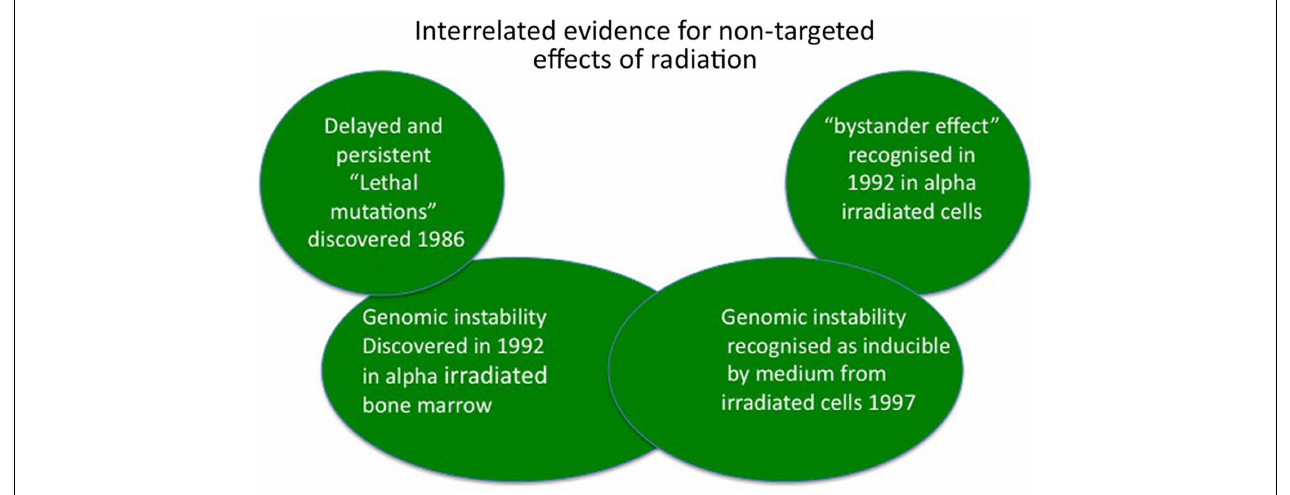
FIGURE 1 | Key initial evidence for non-targeted effects and the interaction between these